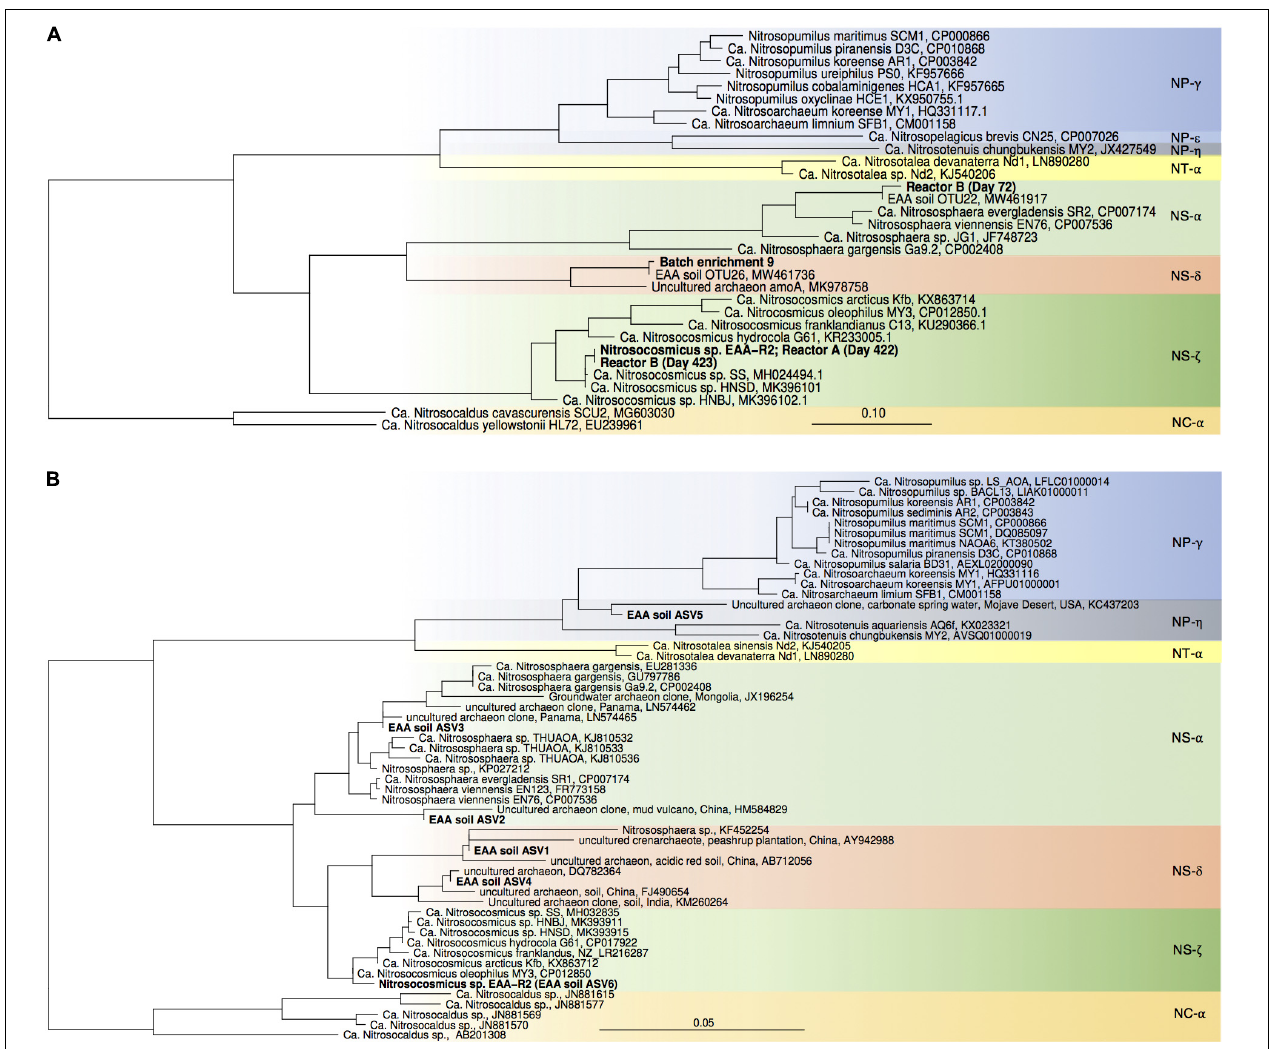
FIGURE 3 | Maximum-likelihood phylogenetic trees of archaeal amoA gene sequences (A) and thaumarchaeal 16S rRNA gene sequences (B) . Sequences obtained in this study are highlighted in bold. Nitrosocaldus sp.-associated sequences were used as outgroup. Color codes refer to archaeal lineages (after Alves et al.,